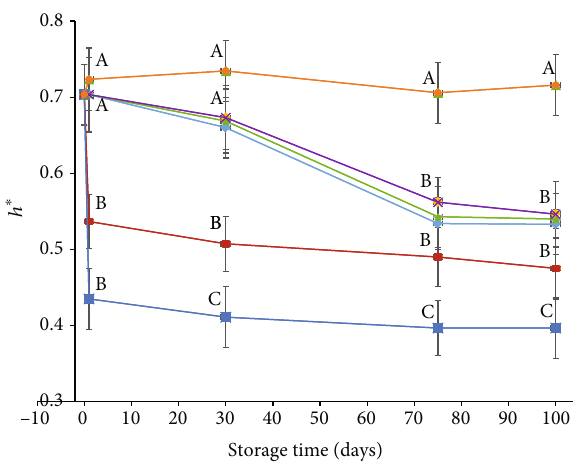
Figure 3: Hue index for di ff erent preservation methods during 100 days of storage at room temperature ( P value < 0.05). Control ( ♦ ), SO ( ● ), cold storage ( ▲ ), blanching three minutes ( ■ ), modi fi ed 2 atmosphere packaging ( ╳ ), blanching ten minutes ( ∗ ). Same letter indicates no statistical di ff erences between